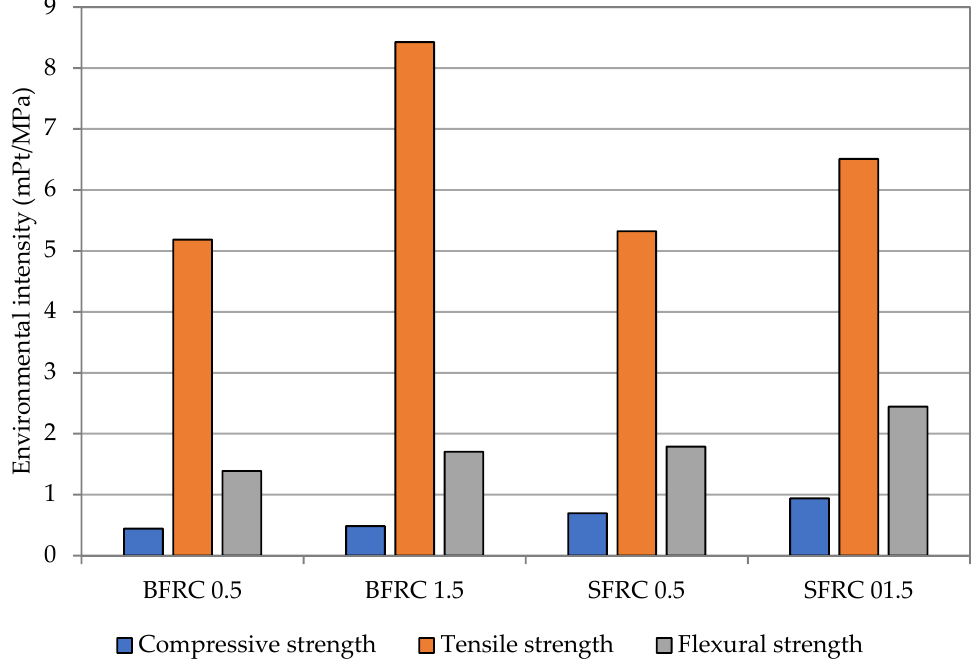
Figure 6. Eco-efficiency comparison of concrete reinforced by basalt and steel fibers.